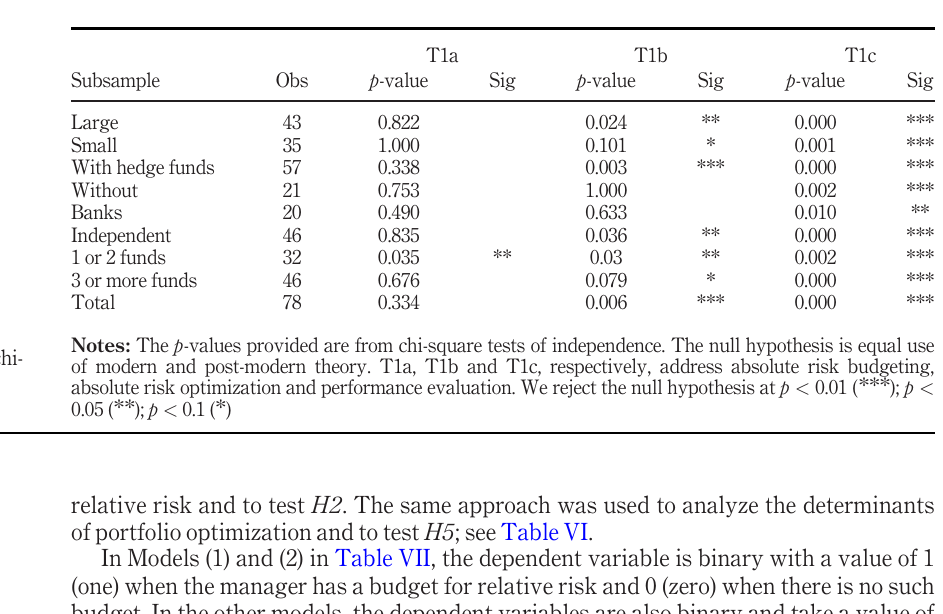
Table IV. Description of H1 variables, tests and